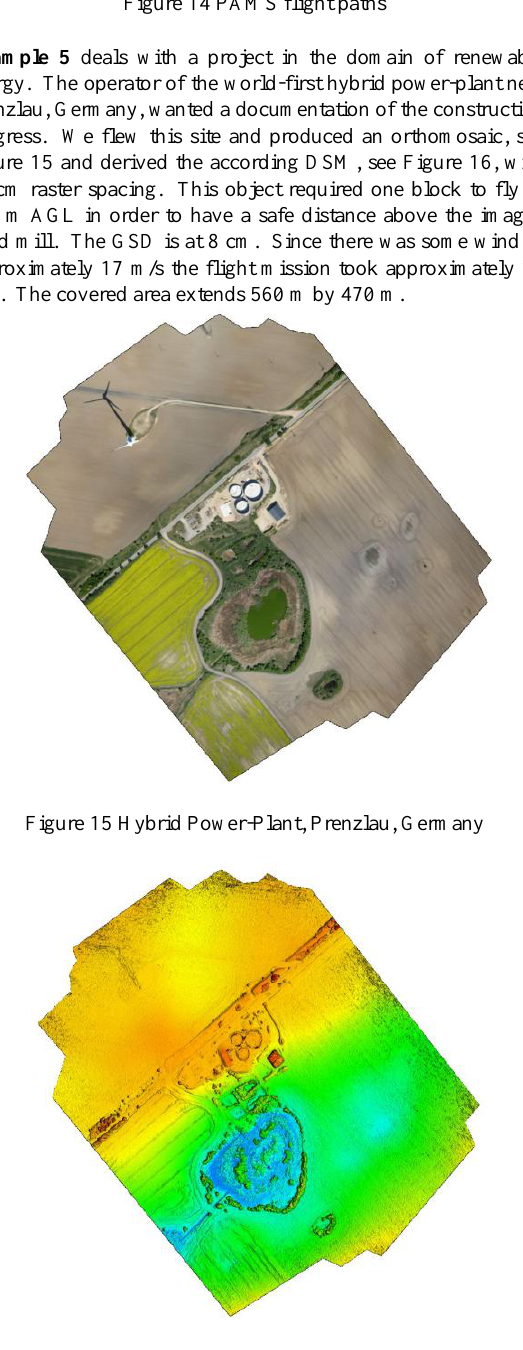
Figure 16 Color-coded DSM of above